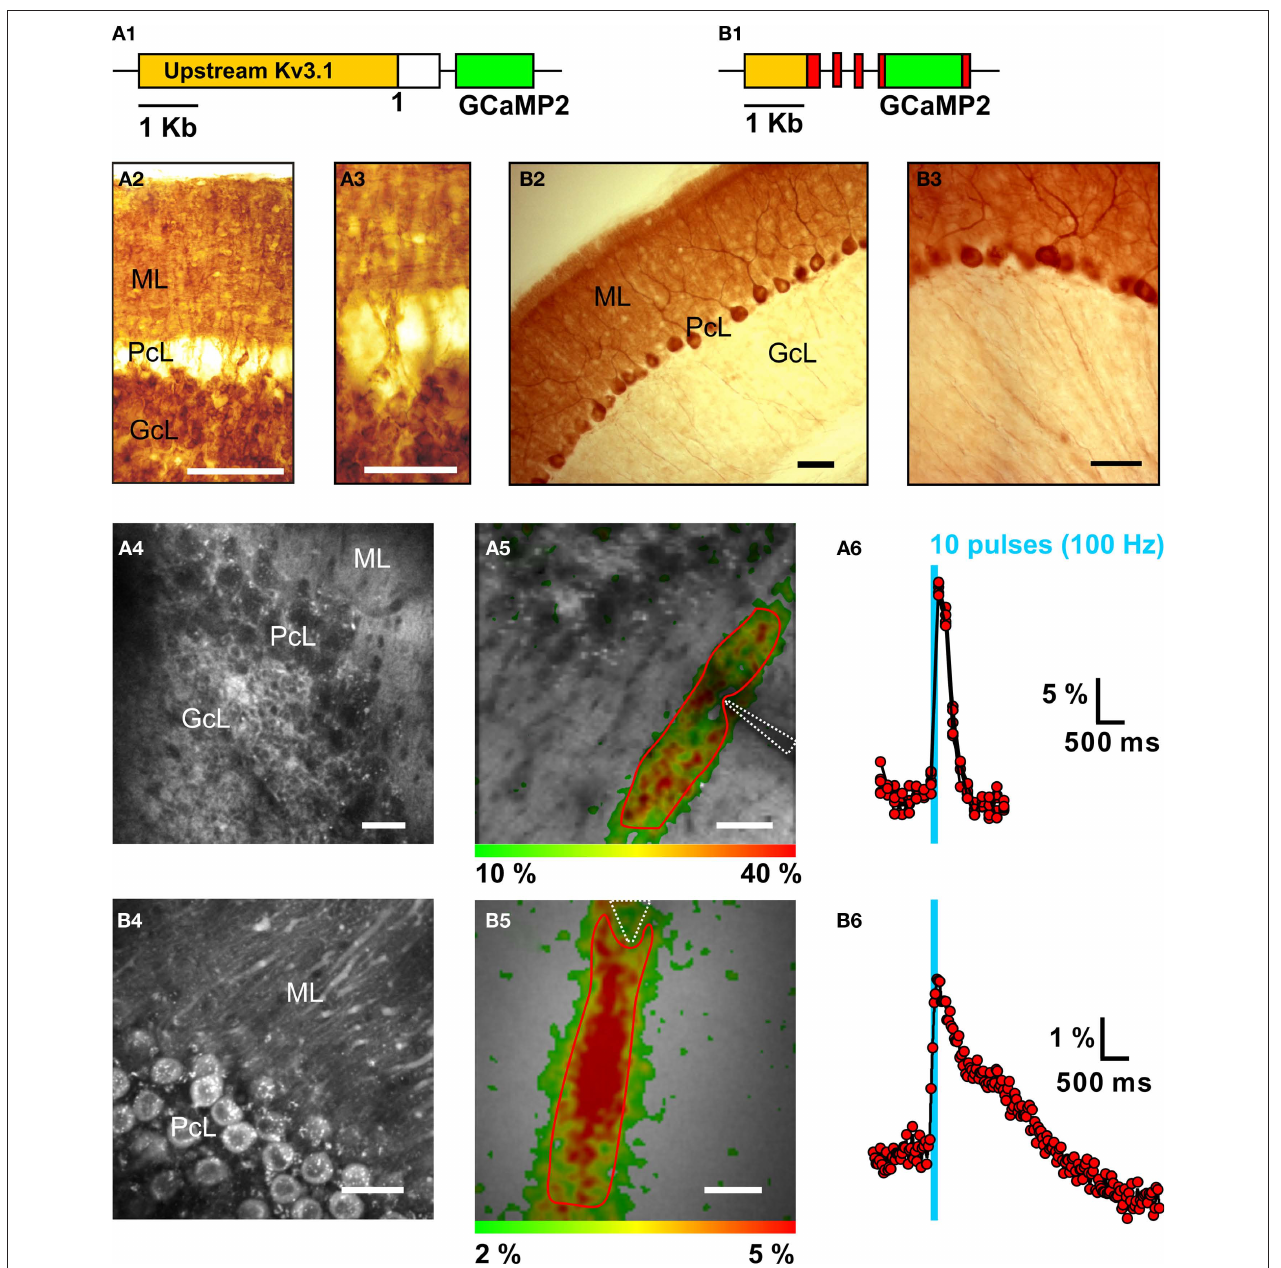
FIGURE 4 | Targeting of the genetically-encoded calcium probe GCaMP2 to granule cells and Purkinje neurons and in-vivo recording of calcium population transients in transgenic mice. (A1) Schematic of the pKv3.1-GCaMP2 gene construct consisting of the extended ( ∼ 6 kb) promoter of the Kv3.1 potassium channel (orange) and GCaMP2 (green). (A2) Immunoreactivity against green fl uorescent protein (GFP) in a coronal cerebellar section from a pKv3.1-GCaMP2-positive mouse showing the granule cell layer (GcL), Purkinje cell layer (PcL) and molecular layer (ML). Scale: 100 µm. Data from: (Diez-Garcia et al., 2005) (A3) Same as (A2) , but different fi eld of view. Scale: 50 µm. (A4) Two-photon image of a craniotomized area (crus I/II; 190 µm below pia) of the cerebellum in a pKv3.1-GCaMP2-positive mouse in-vivo . Scale: 25 µm. (A5) In-vivo stimulation of a parallel fi ber bundle using an external electrode (white dashed lines; 10 pulses; 100 Hz) with the GCaMP2 responses ( Δ F / F ) coded according the color scale below. Scale: 50 µm. (A6) Time course of